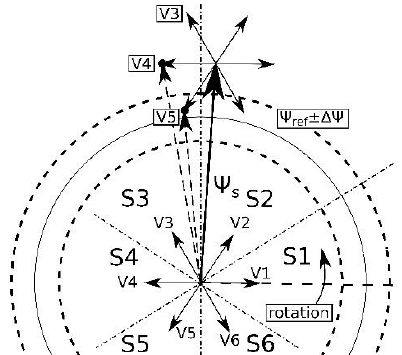
Figure 5. Voltage vector selection during the flux sector transition. In the case of DTC, the voltage vector V4 is selected. This vector does not suit the criteria to decrease the flux level. In the case of PTC, the voltage vector V5 is selected.